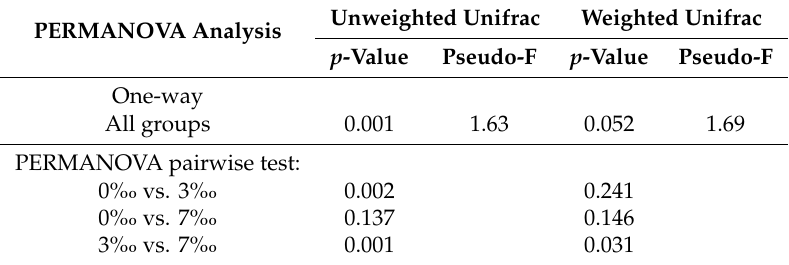
Table 2. Permutation multivariate analysis (PERMANOVA) of weighted and unweighted Unifrac data of intestinal microbiomes of pike living in di ff erent